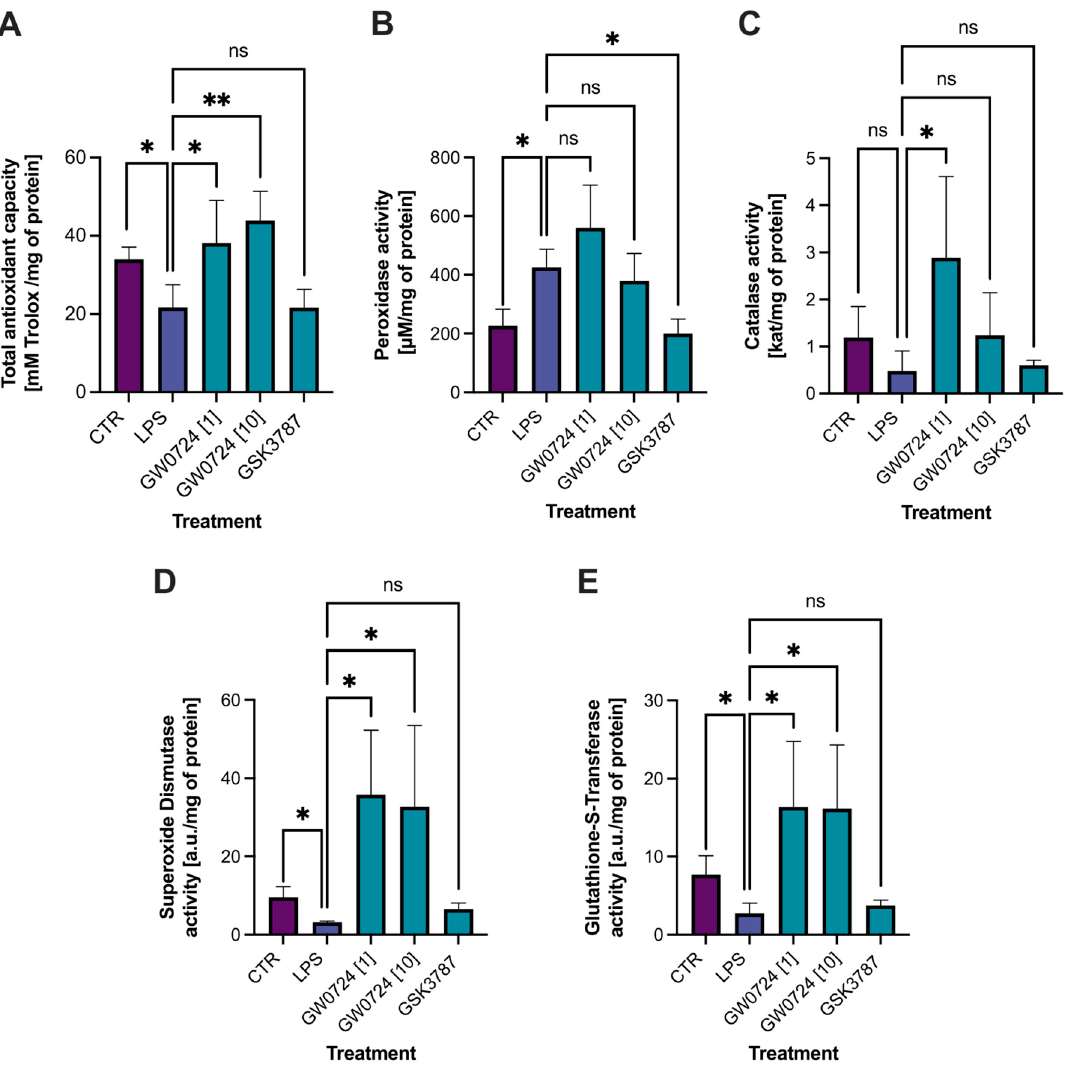
Figure 6. Different biochemical indicators of oxidative stress in corpus luteum treated with LPS or with LPS and PPAR β / δ agonist (GW0724 at a concentration of 1 µ mol/L or 10 µ mol/L) and antago- nist (GSK3787). Visualization of results of performed biochemical analyses: total antioxidant capacity ( A ), peroxidase activity ( B ), catalase activity ( C ), superoxidate dismutase activity ( D ), glutathione- S-transferase activity ( E ). Results were considered statistically significant at p ≤ 0.05 (*) and p ≤ 0.002 (**); ns: not significant.